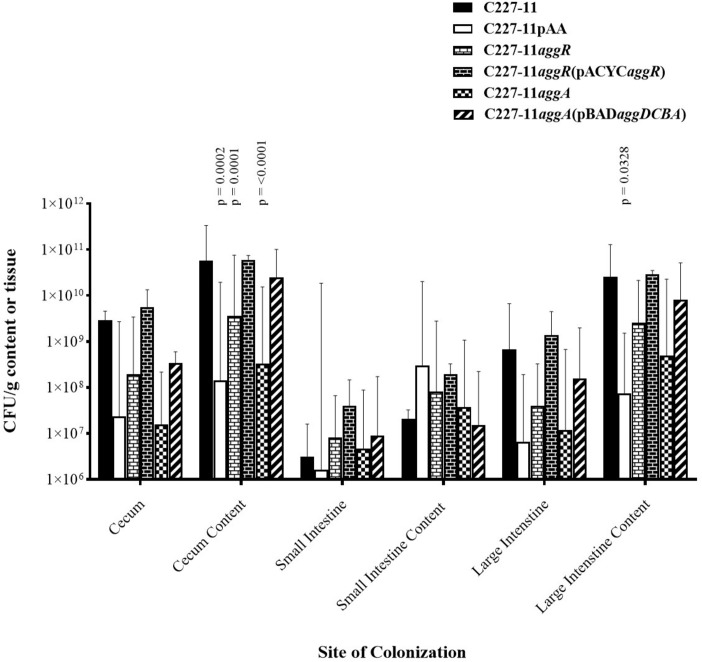
Colonization 24 h after oral infection by wild-type EAEC strain C227-11 or mutants (C227-11pAA–, C227-11aggR, C227-11aggA) or complemented strains [C227-11aggR(pACYCaggR), and C227-11aggA(pBADaggDCBA)] at different sites within the gastrointestinal tract of Amp-treated C57BL/6 mice. Both the tissues (cecum, small intestine, and large intestine) and contents thereof were weighed, diluted in DMEM (1:10, wt/vol), and homogenized. Colonies from supernatants were enumerated to determine the number of CFU/g sample. Each bar represents the geometric mean with geometric mean SD from four mice. Differences between C227-11 and mutants were determined by ANOVA multiple comparison with uncorrected Fisher’s (LSD) at each site. The significant differences between mean colony count at each site were as follows; cecum content, C227-11 vs. C227-11aggA, p = < 0.0001. C227-11 vs. C227-11pAA–, p = 0.0002. C227-11 vs. C227-11aggR, p = 0.0001. Large intestine content, C227-11 vs. C227-11pAA–, p = 0.0328.